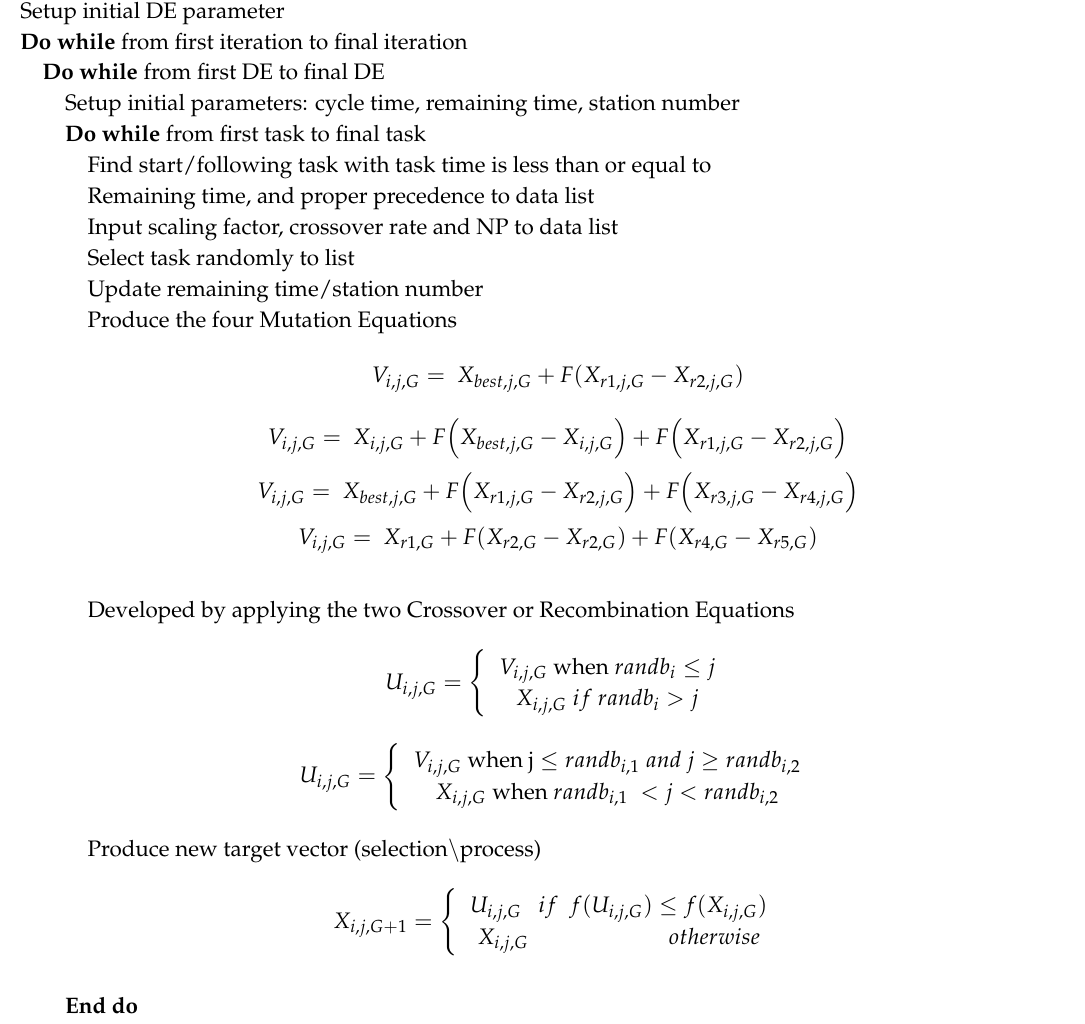
Algorithm 1. Pseudo-code of the DE for (UALBP-1) Setup initial DE